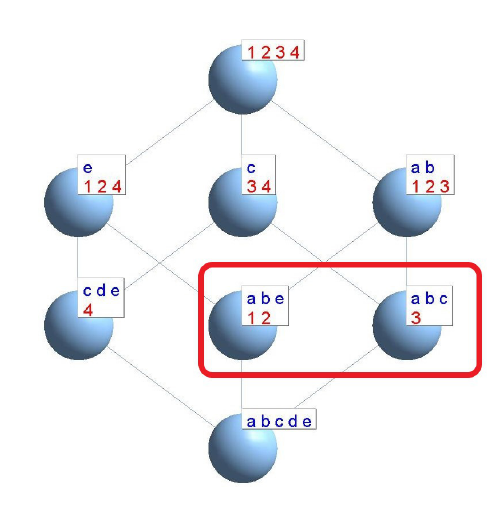
Figure 3. Explored lower neighbor concepts for computing the stability of { ( 1,2,3 ) , ( a , b ) }